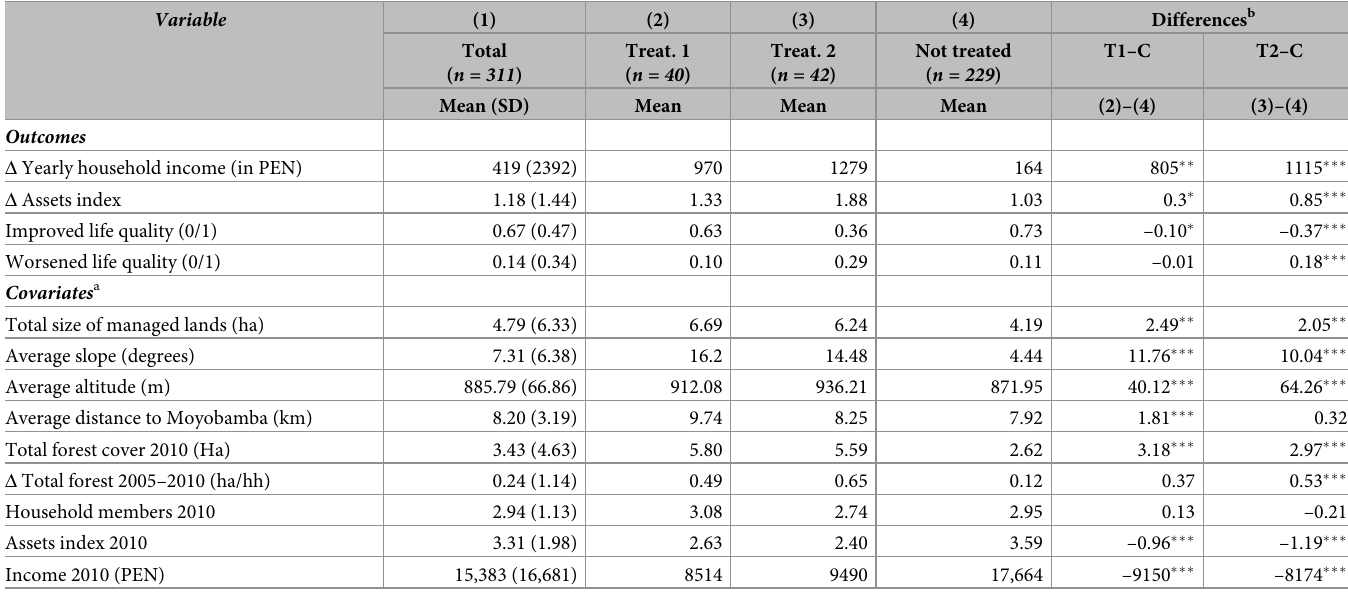
Table 2. Summary statistics for the household welfare